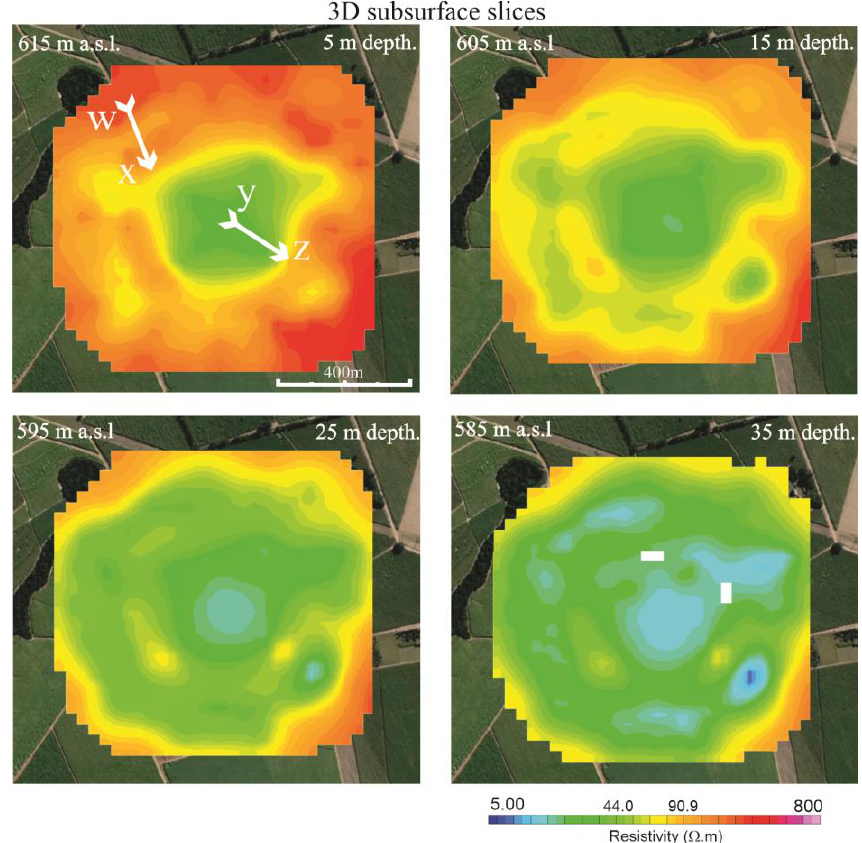
Figure 8. 3D subsurface slices visualization models, slices of the 3D blocks, resulting from lateral interpolation of 2D inversion models. Depth of 5, 15, 25, and 35 m.